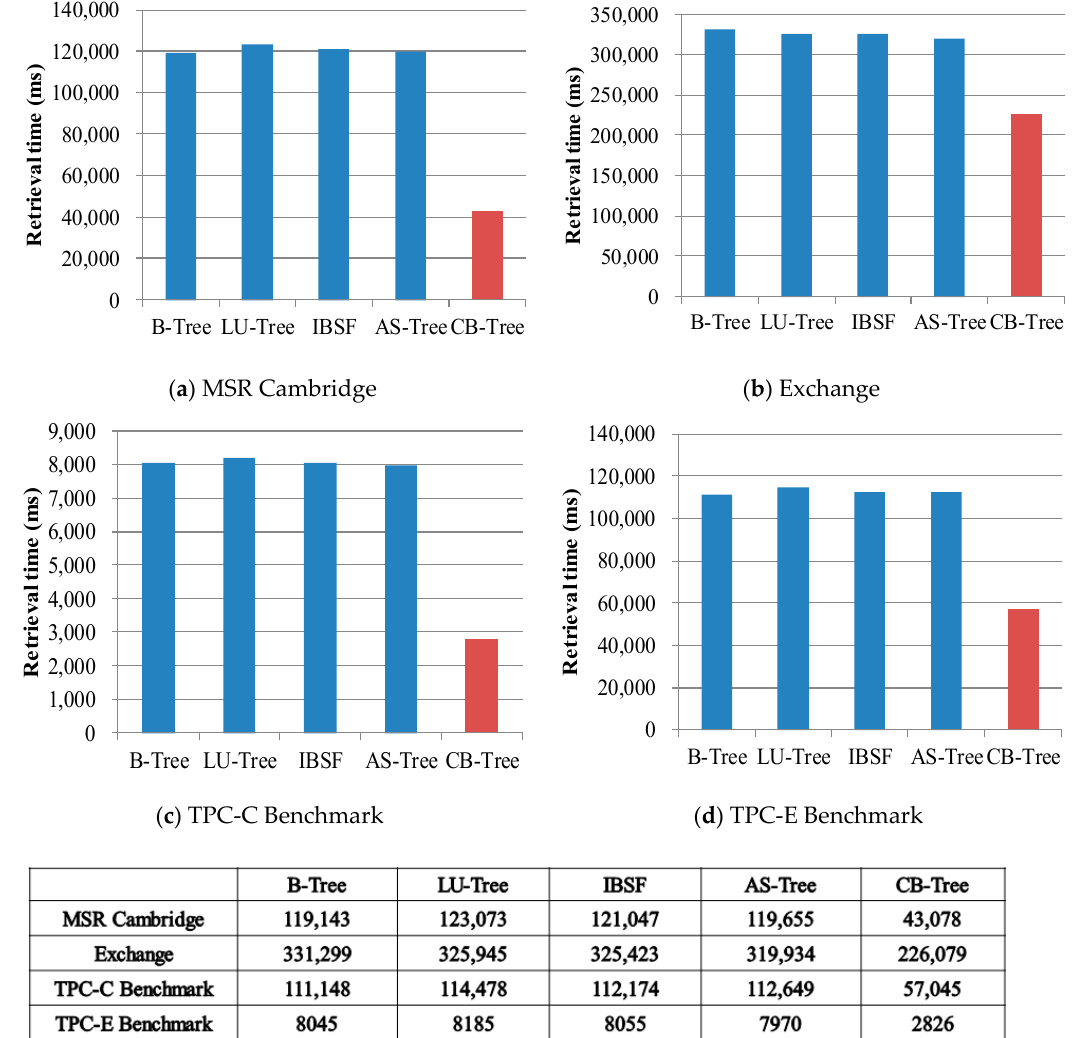
( d ) TPC-E Benchmark Figure 13. Creation time in buffer-based B-trees (total elapsed time). Most of buffer-based B-trees including IBSF reduce the number of write operations for leaf node updates by simply employing a write buffer. However, since they do not consider flash operations for updating parent nodes and merging or splitting leaf nodes, the performance degradation may occur. In CB-tree, we exploit cascade memory nodes to avoid many updates for parent nodes and node splits for the leaf node in the case of sequential insertions. As a result, we confirmed that CB- tree quickly builds its index structure compared to the other buffer-based B-trees. Figure 14 shows the total retrieval time when the trees perform each read request as shown in Table 5. The B-tree without any buffer performs the same number of read operations as its tree height in every read request. Since LU-tree, IBSF, and AS-tree store some records in the main memory, these records are also used in retrieval operations. Before traversing nodes to find a record, they first search